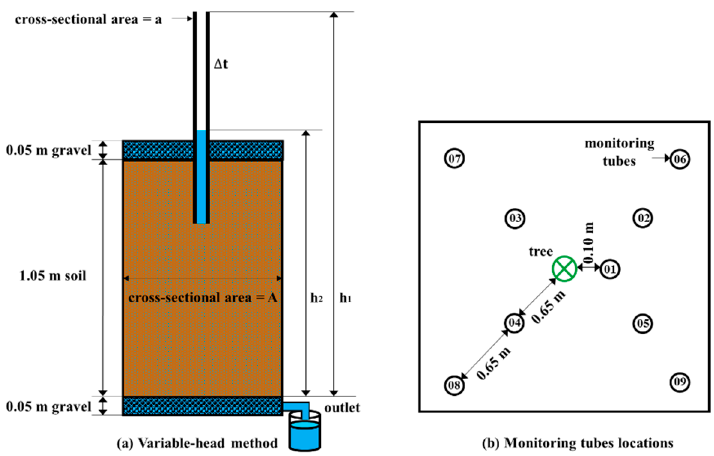
Figure 3. Schematic view of ( a ) the constant-head monitoring method experimental setup, showing the position of ( b ) the horizontal monitoring tubes. ( V is the volume of the measuring vessel / container and t is the time (in days, converted from recorded minutes) taken for the vessel to be filled with water running from each horizontal monitoring tube).